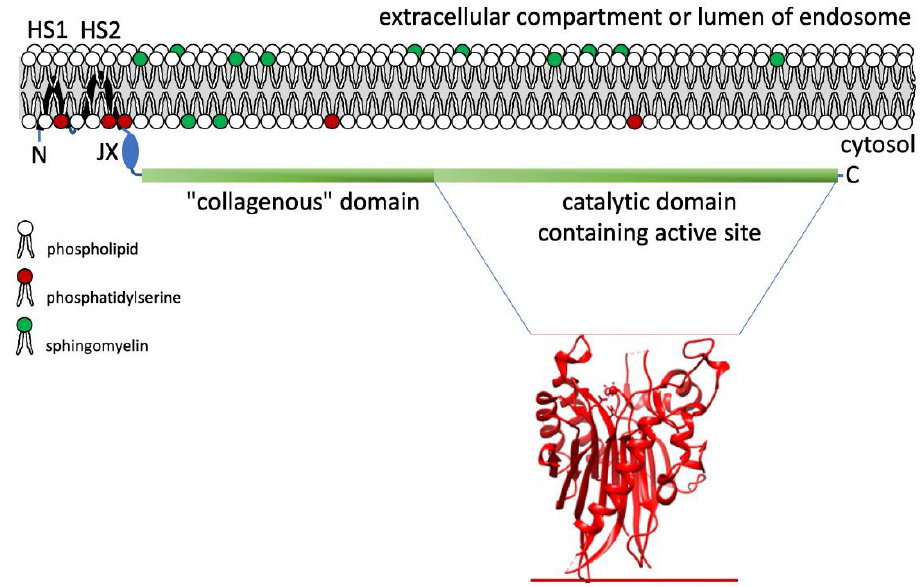
Figure 2. Membrane topology of nSMase2 and tertiary structure of the C-terminal part of the catalytic domain. The domain organisation and topology of the domains are derived from [73]. The tertiary structure is based on coordinates taken from [74]. N: N-terminus. HS1 and HS2: Hydrophobic segments 1 and 2. JX: domain juxtapositioned to the domain with the hydrophobic segments and critical for allosteric activation. C: C-terminus.